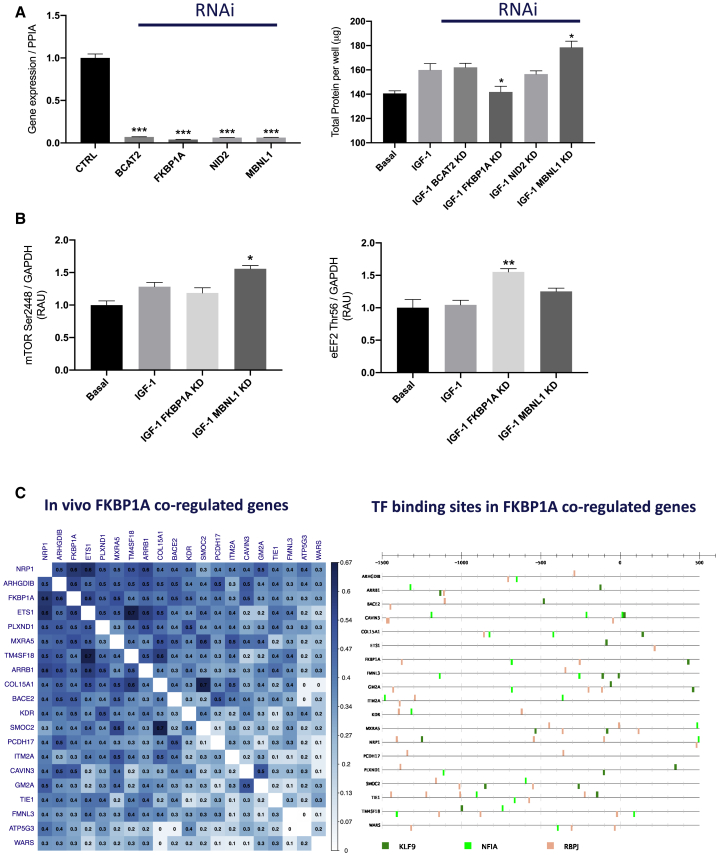
Growth-Regulated Genes Modulate Protein Synthesis and Anabolic Signaling in Human Muscle CellsRNAi targeting of individual members of the muscle mass-related gene network.(A) mRNA expression of BCAT2, FKBP1A, NID2, and MBNL1 relative to their own control (100%) following treatment with a pool of multiple siRNAs targeting each gene (BCAT2, FKBP1A, NID2, and MBNL1), with IGF-1 used to increase primary muscle cell protein synthesis. *p<0.05, **p<0.01, ***p<0.001.(B) Calculation of relative arbitrary units (RAUs) for mTOR Ser2448 and eEF2 Thr56, using phosphospecific antibodies (IGF-1 treatment in primary muscle cell in the presence or absence of FKBP1A and MBNL1 RNAi). *p<0.05, **p<0.01, ***p<0.001.(C) Correlation matrix of the in vivo changes in gene expression covarying with the change in FKBP1A. All of the genes were also correlated with exercise training-induced alterations in muscle lean mass (see Method Details). Transcription factor binding site enrichment analysis (−1,500 to +500 nt from the start codon using CiiiDER and controlled for bias in the muscle transcriptome) revealed that 3 transcription factors (KLF9, NFIA, and RBPJ) potentially coordinate this FKBP1A-angiogenesis related transcriptional “module” (i.e., they are not enriched in the larger lean-mass growth-related transcriptional signature).